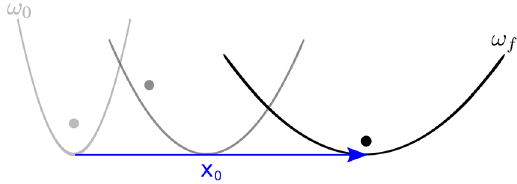
Figure 1. Scheme of the transport protocol with a change in the frequency of the